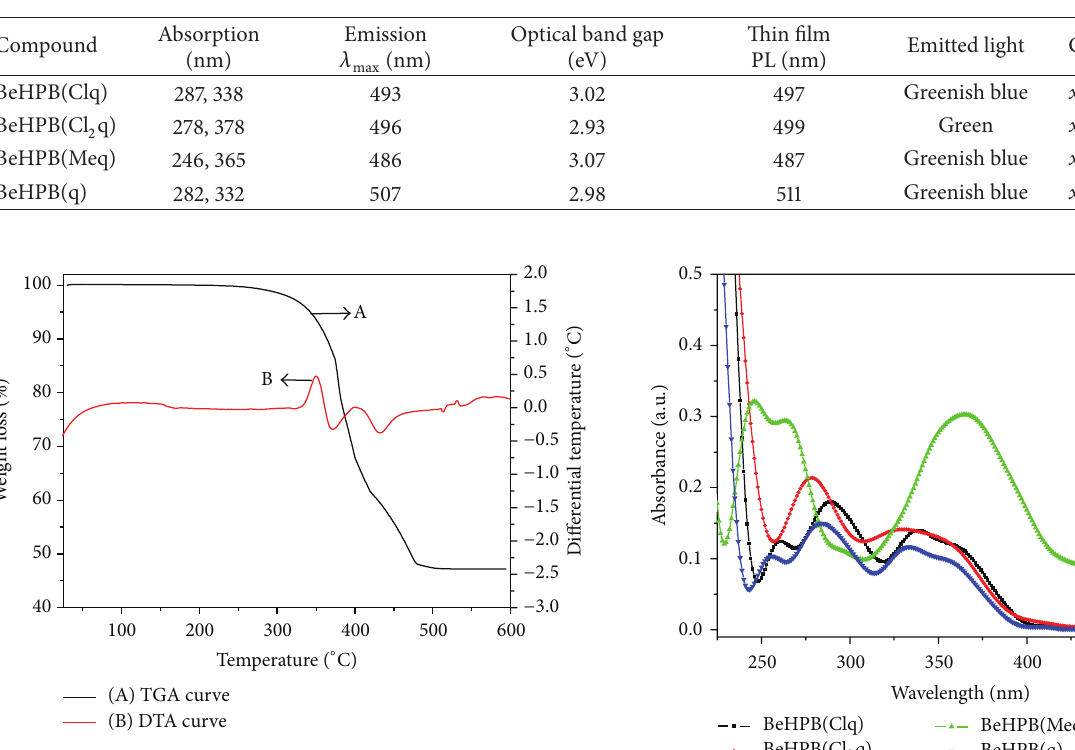
Table 1: Photophysical properties of beryllium complexes.